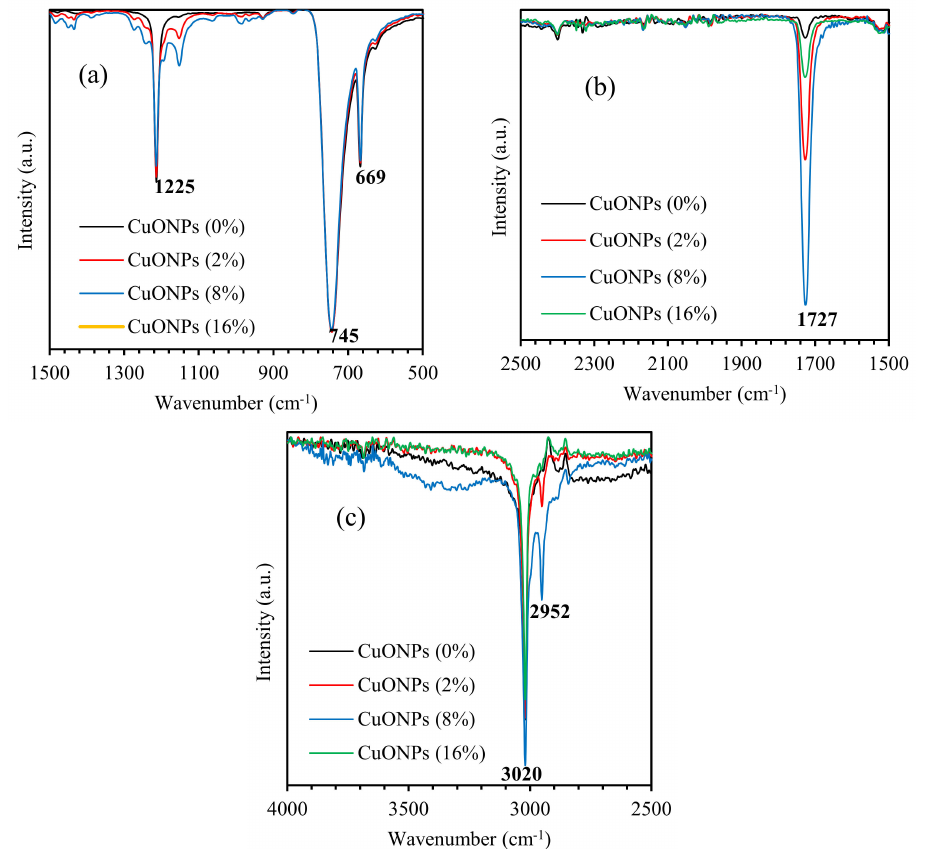
Figure 14. FTIR spectra of PMMA–PVA/CuO nanocomposite thin films in the spectral ranges: ( a ) 500–1500 cm − 1 , ( b ) 1500–2500 cm − 1 , and ( c ) 2500–4000 cm − 1